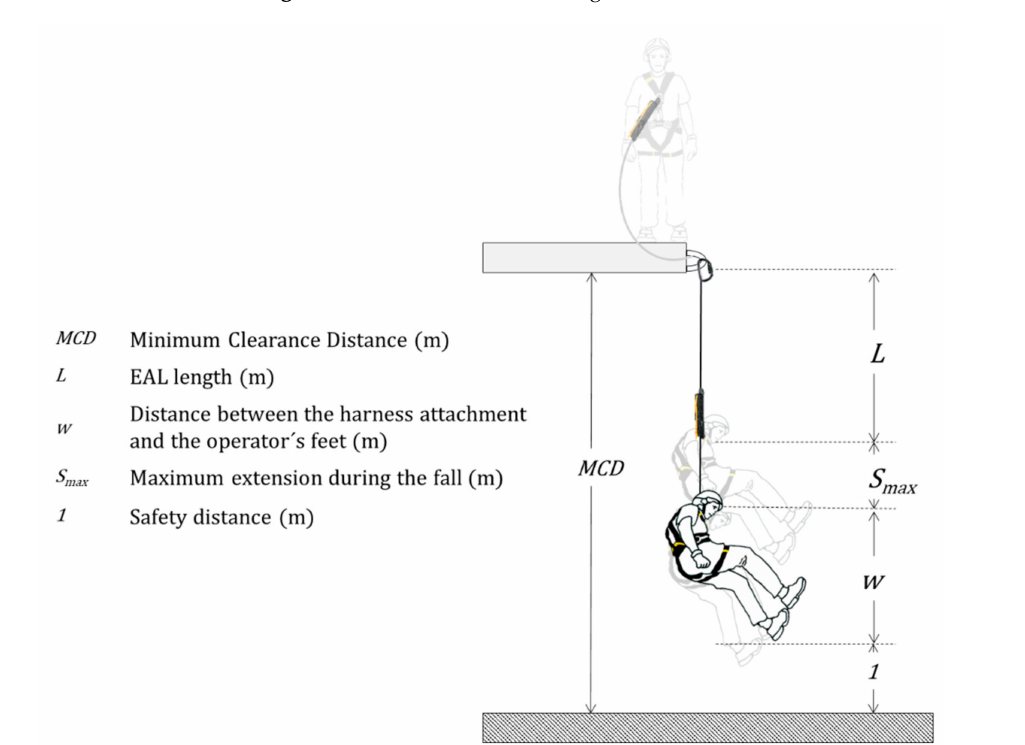
Figure 3. Relevant distances in